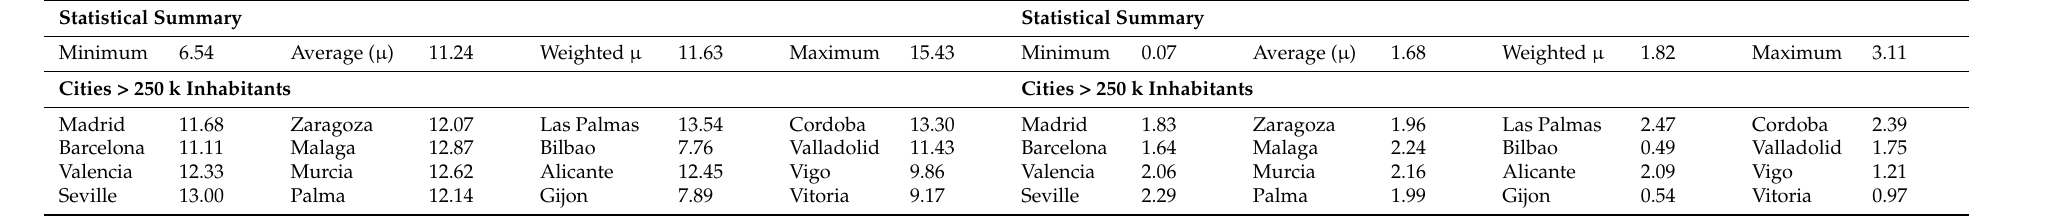
Figure A4. PV NPV in thousand euros (S1 (consumption saving scenario) left , and S2 (surplus sale scenario) right ).